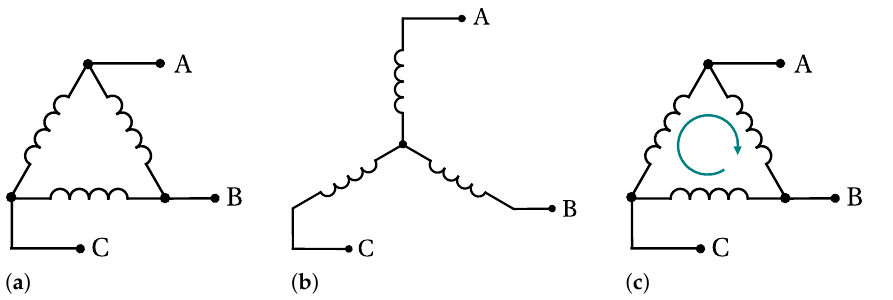
Figure 29. Delta and star connections. ( a ) Delta-connection. ( b ) Star-connection. ( c ) Circulating